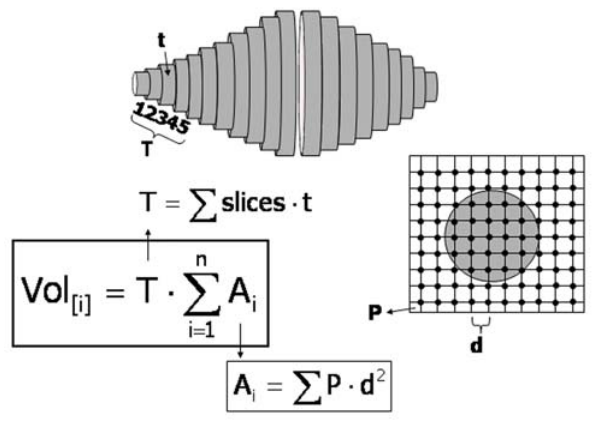
Fig. 5 – Cavalieri’s principle and the organ volume estimation. The organ is serially cut with uniform thickness (t). For example, one every five sections (T=5t) is measured to determine area (for example by point counting method: in a square array test system the point area is calculated as the square of the distance between points, d).